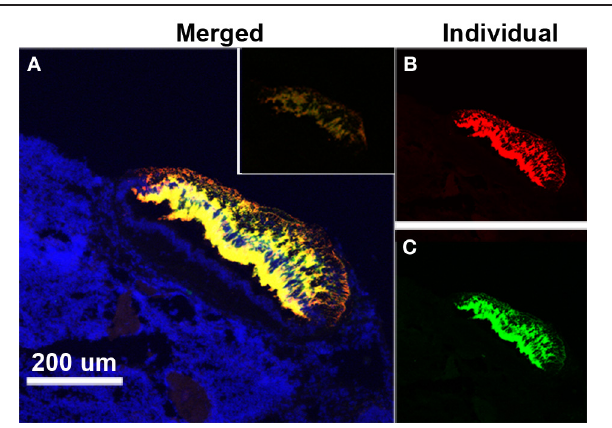
FIGURE 3 | Expression of lGnRH-R-2 and R-3 RNA in the pineal of a female lamprey using in situ hybridization. (A) The merged channel (displayed as yellow) shows the composite of “anti-sense” expression of lGnRH-R-2 (Cy3-red channel) and lGnRH-R-3 (FITC-green channel) while DAPI (blue) is used to show the surrounding cell structure. The inset shows the control “sense” hybridization. The smaller panels have the lGnRH-R-2 (B) and lGnRH-R-3 (C) signals displayed